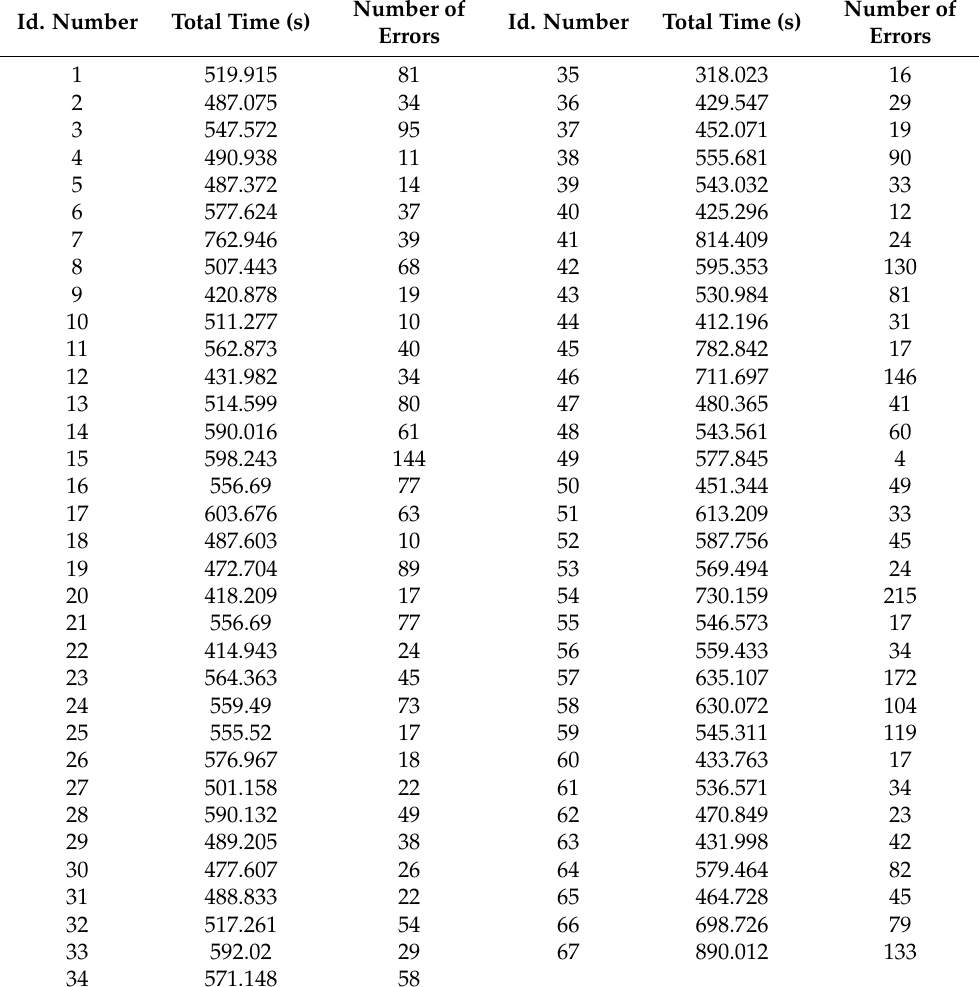
Table 1. Reaction time measurement